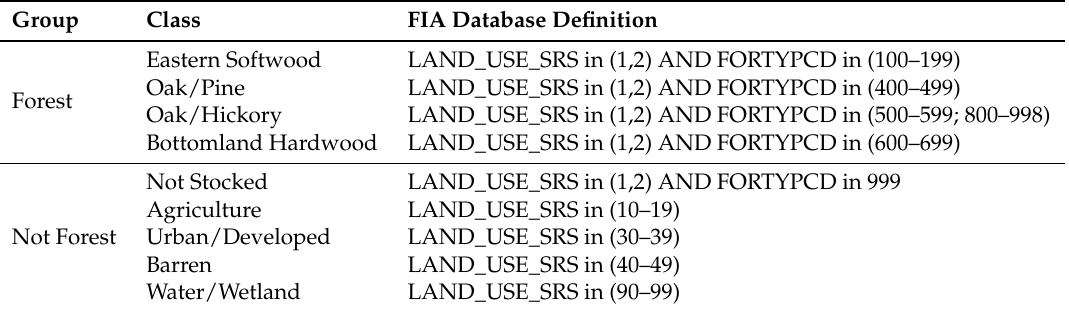
Table 2. Custom Land Use/Forest Type classification. Variable names refer to those in the FIA Database